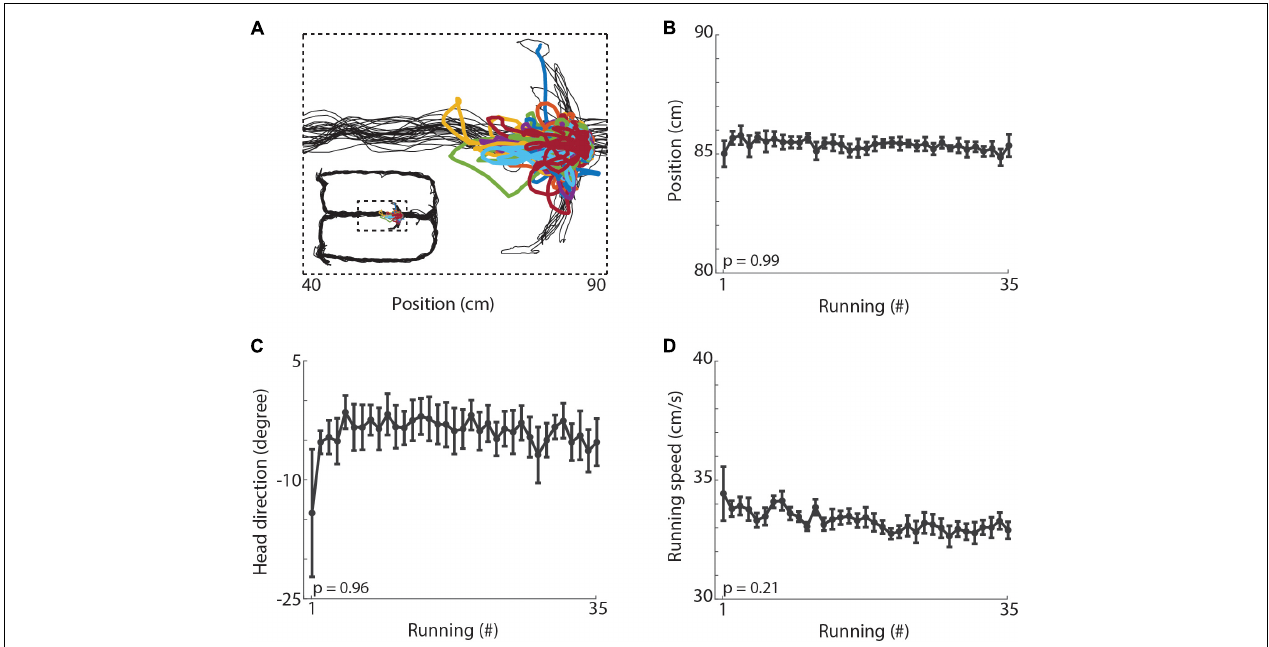
FIGURE 7 | Behavioral variables. (A) Example of locomotion trajectories during maze laps (black lines) and treadmill runs (colored lines). (B) Mean position of the animals during treadmill runs across the 35 running periods ( p = 0.99, repeated measures ANOVA). Circles denote mean and error bars indicate ± SEM ( n = 11 sessions from 3 animals). (C) Mean head direction during treadmill running ( p = 0.96, repeated measures ANOVA). The left-to-right treadmill axis is represented by zero degrees. (D) Mean running speed during each of treadmill run ( p = 0.21, repeated measures